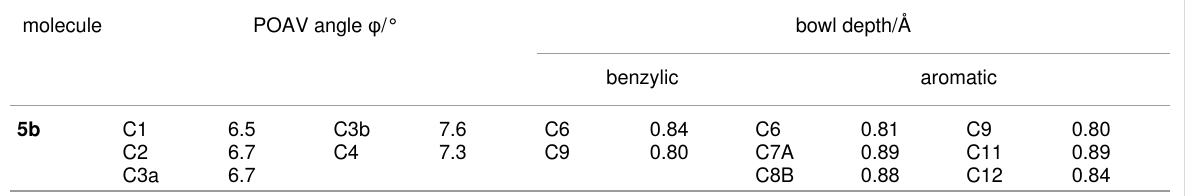
Table 2: Experimental POAV angles and bowl depths of 5b at the specific focused carbons.